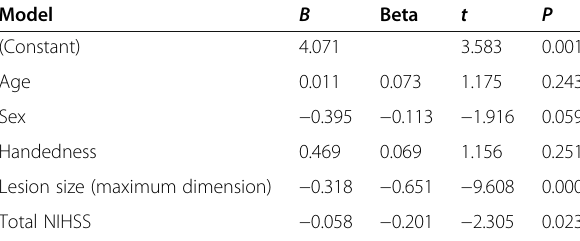
Table 7 Multivariable regression analysis for severity of